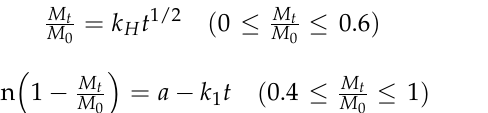
Figure 6. STR release profiles in PBS for ACP ( a ) and cHAp ( b ) nanoparticles loaded with STR ac- cording to the different studied methods.